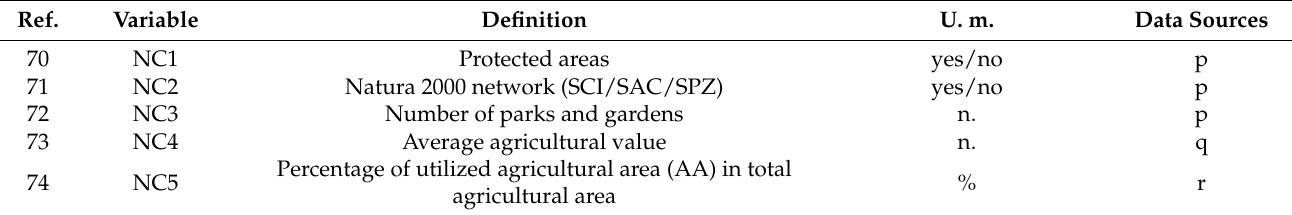
Table 5. Natural capital indicators.